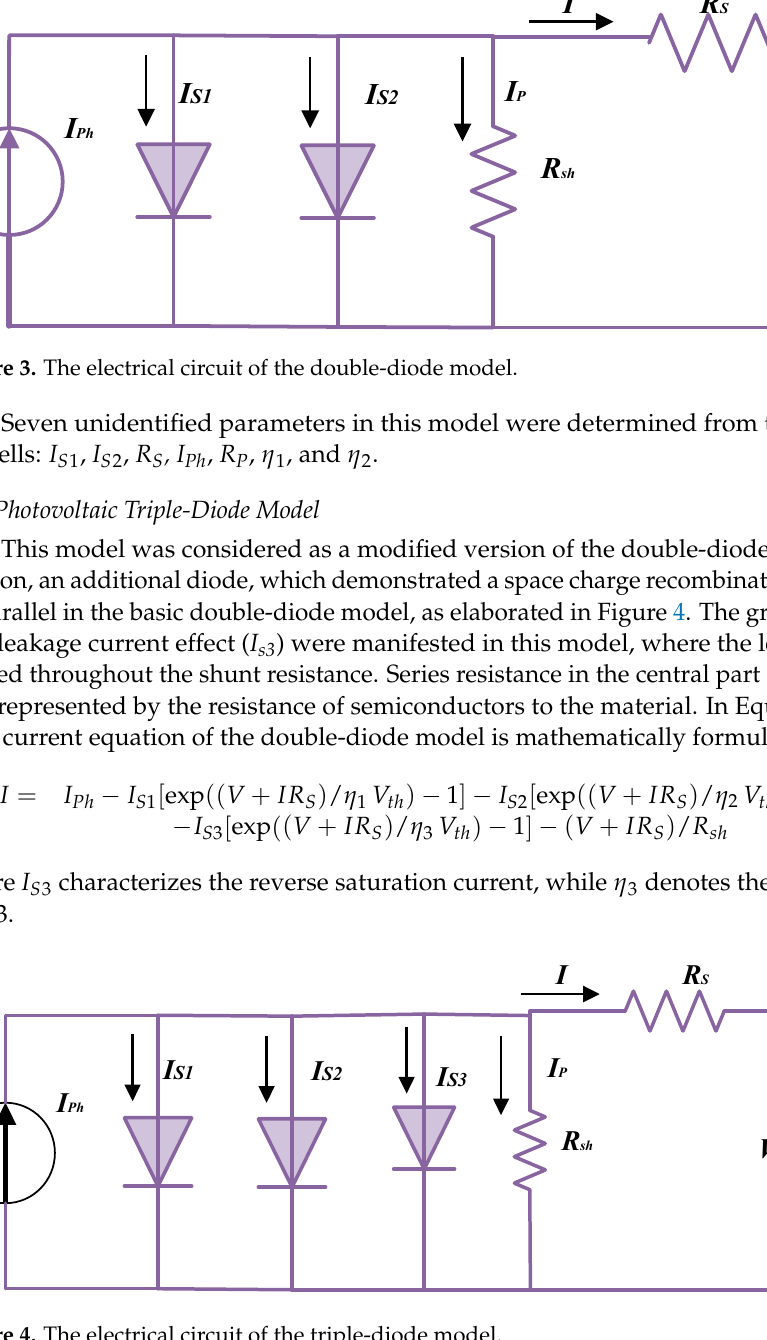
Figure 4. The electrical circuit of the triple-diode model.